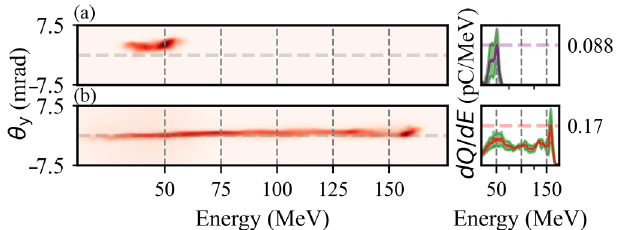
FIG. 5. Experimental electron charge density in divergence- energy space and their corresponding spatially integrated dQ=dE (pC MeV − 1 ) within a (cid:2) 7 . 5 m rad window around the laser axis indicated by the dashed horizontal gray line with the laser focus at z ¼ − 0 . 35 mm for the two exit plate configurations illustrated in Fig. 4: (a) short exit configuration (SE) case, and (b) long exit configuration (LE). Standard deviation of four and three con- secutive shots for (a) and (b), respectively, are illustrated by the shaded green region. All dQ=dE plots are plotted from zero (pC MeV − 1 ) in linear scaling. The purple and red dashed lines indicate the maximum value of dQ=dE for the displayed